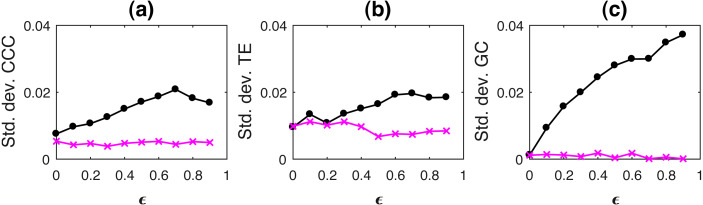
Standard deviation of causality values estimated using CCC (A), TE (B) and GC (C) for coupled AR(1) processes, from Y to X (solid line-circles, black) and X to Y (solid line-crosses, magenta) as the degree of coupling, ϵ is varied.